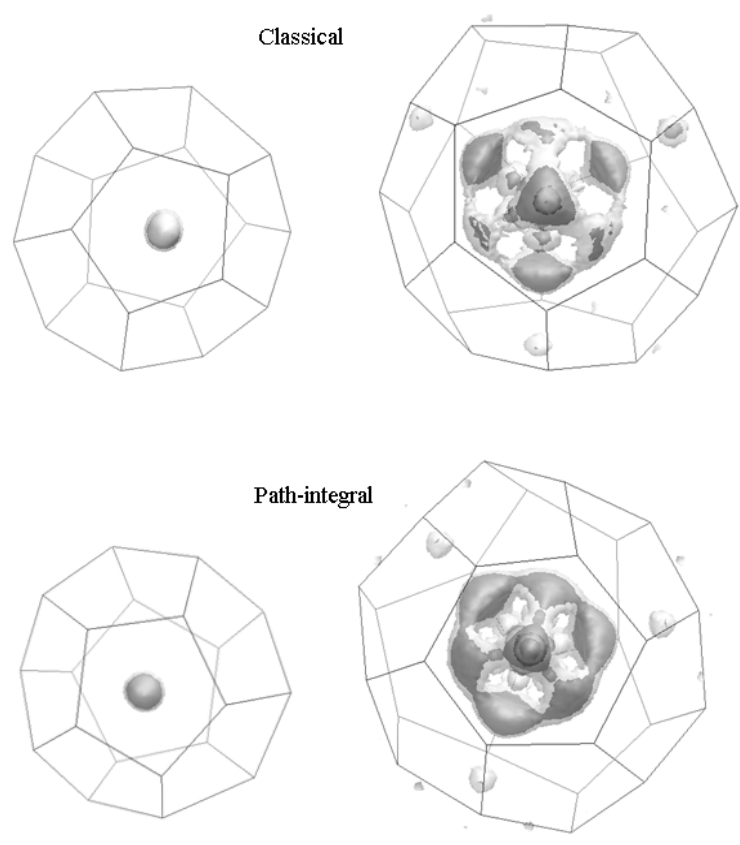
Figure 1. Spatial density isosurface plots (0.1 Å) at 100 K in singly and doubly occupied small and large cages.